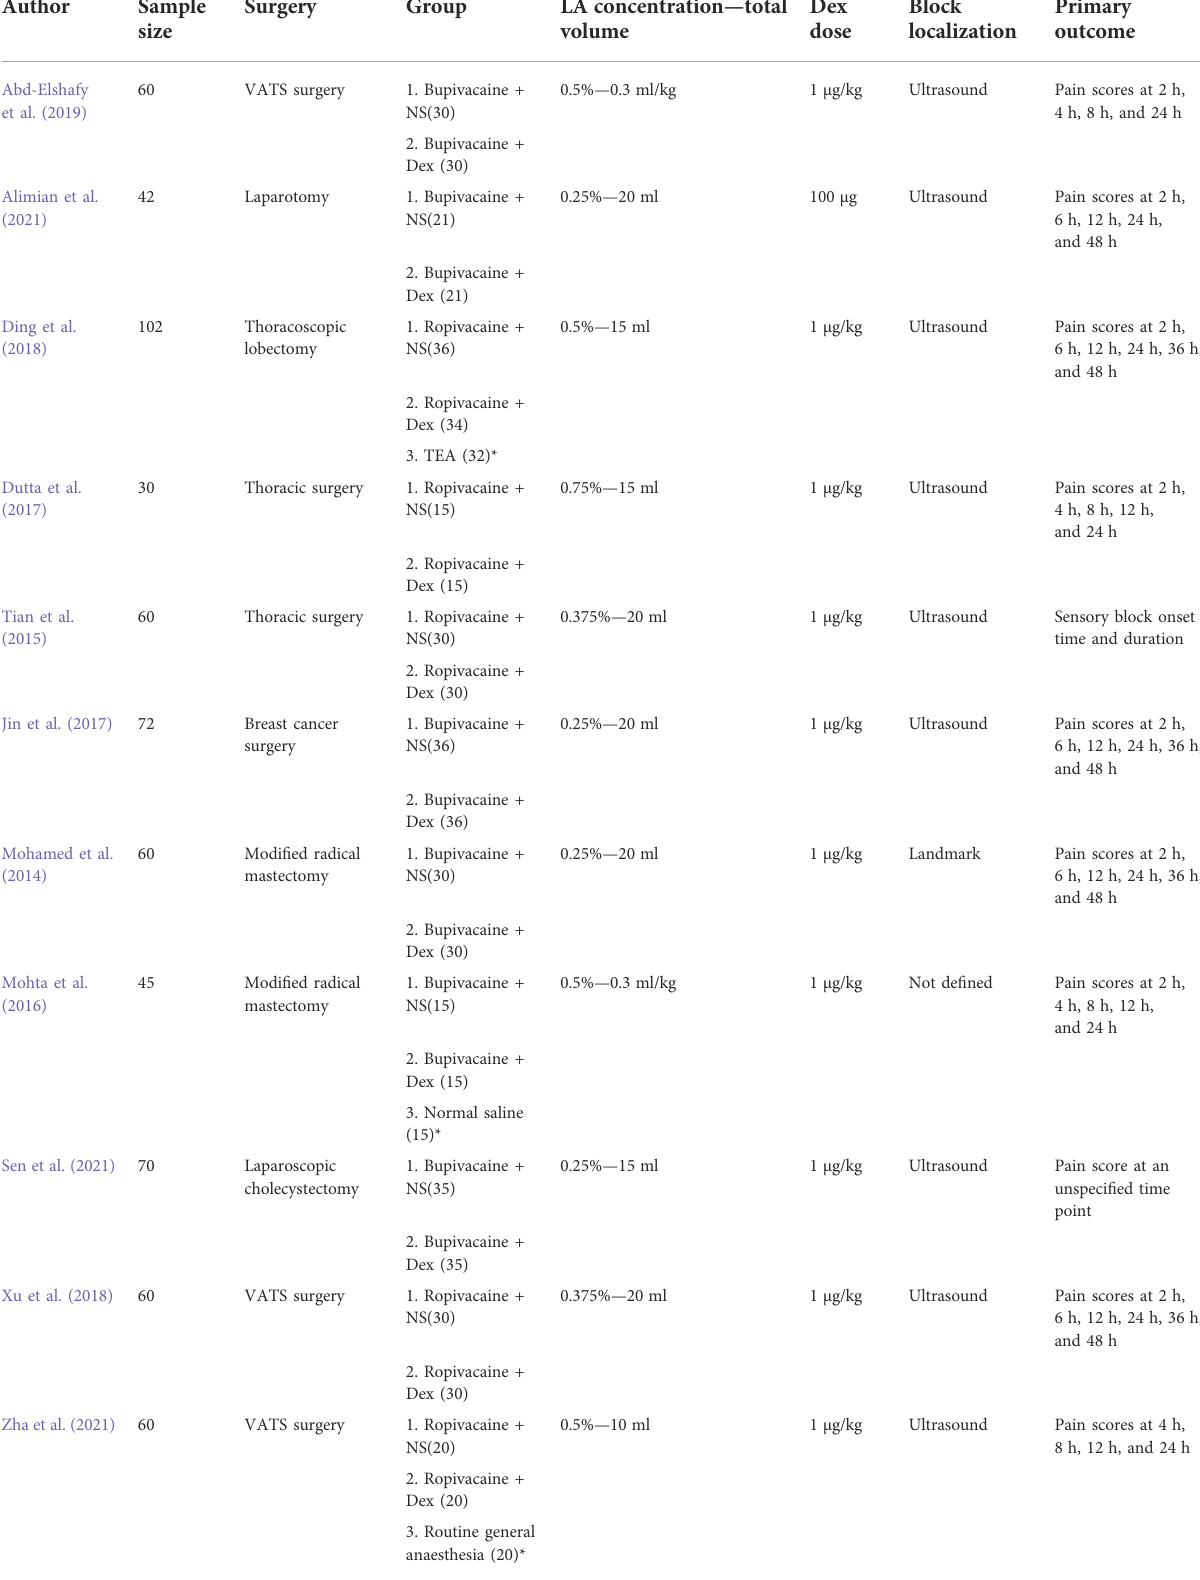
TABLE 1 Trial characteristics and outcomes